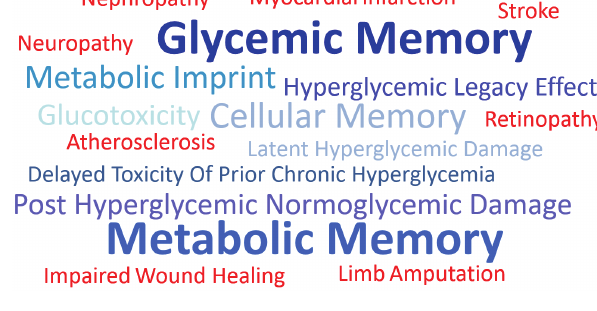
Figure 1: Word cloud illustrating diverse nomenclature for glycemic memory and associated diabetic